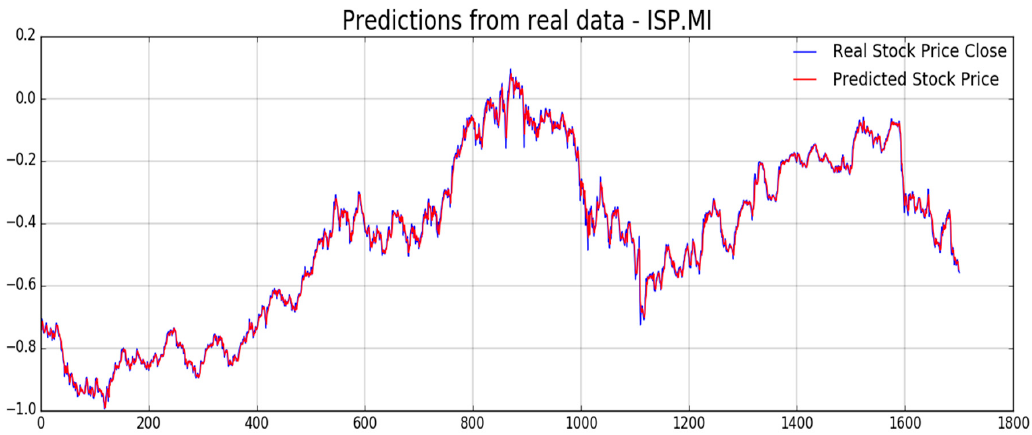
Figure 14. ISP.MI Close Price time-serie (red: predicted; blue: real value).